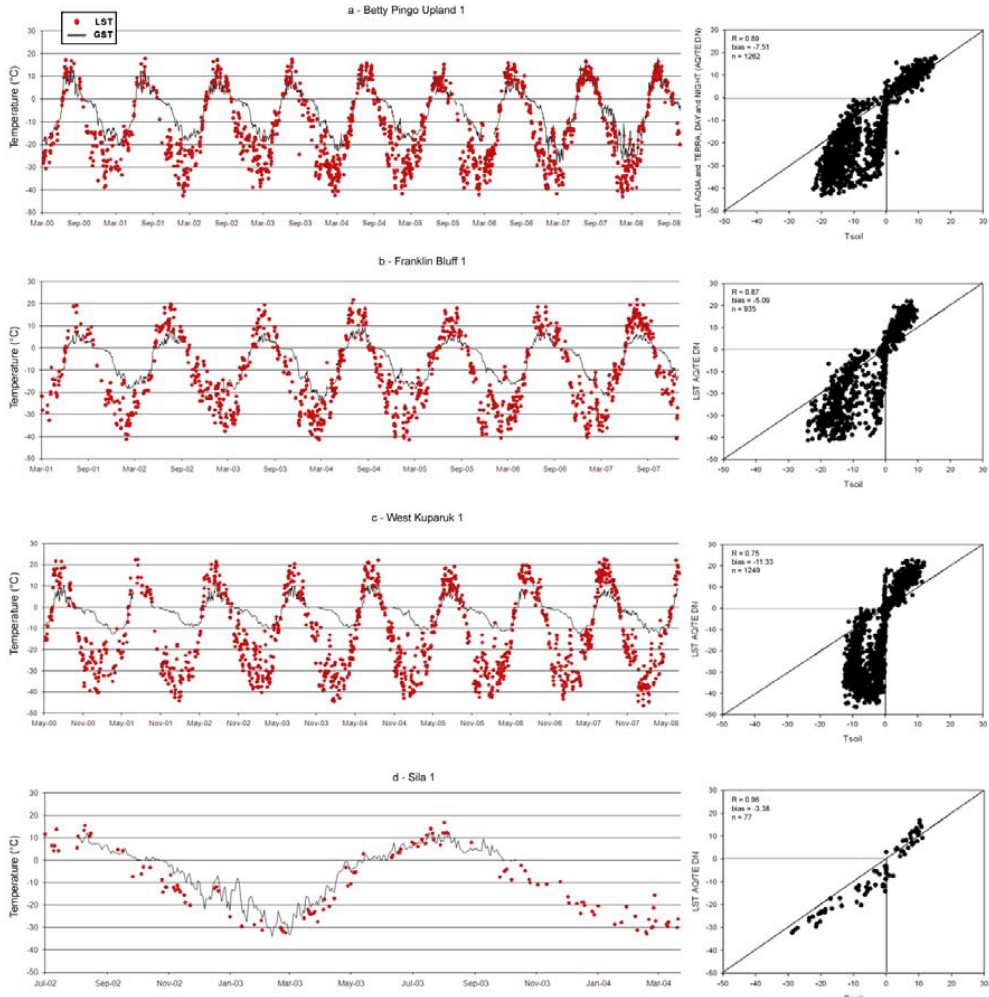
Fig. 2. Relation between mean daily MODIS LST (combined Terra and Aqua) and mean daily GST at (a) Betty Pingo Upland (BPU1), (b) Franklin Bluff (FB1), (c) Western Kuparuk (WK1), and (d) Sila (Sila1).